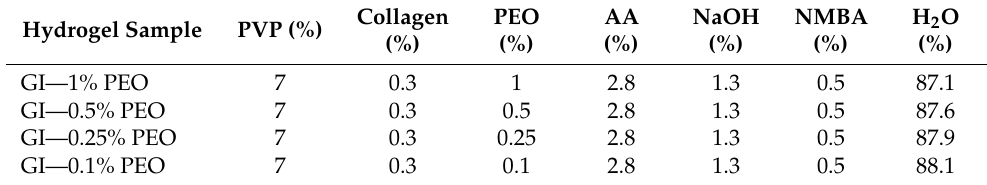
Table 5. Composition of hydrogels with various concentrations of poly (ethylene oxide) (PEO). Hydrogel